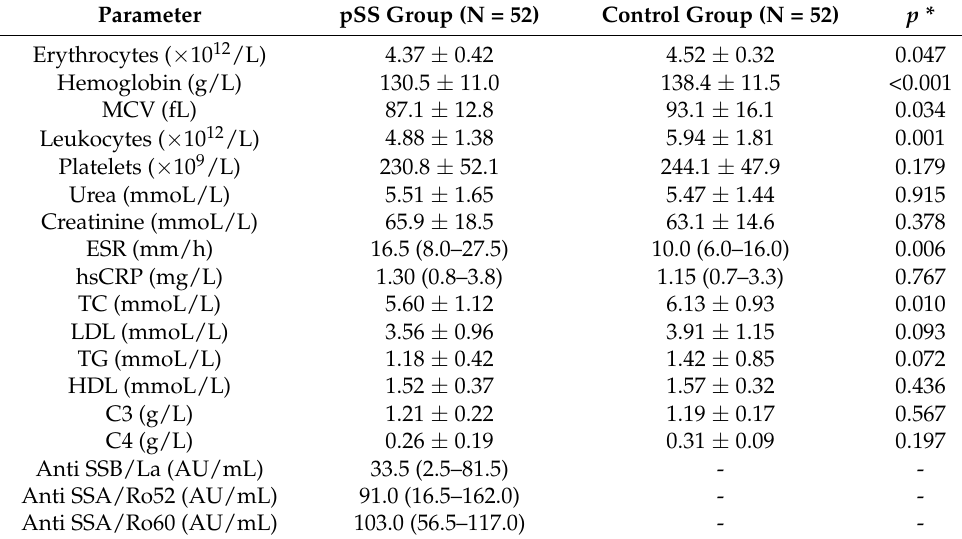
Table 2. Laboratory parameters of pSS patients and healthy controls.